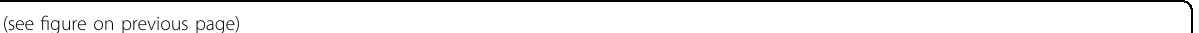
Fig. 1 Prpf19 modulates the poly-ubiquitination and degradation of expanded ATXN3-polyQ protein and also mediates ATXN3-polyQ- induced cytotoxicity. a Overexpression of Prpf19 degraded the level of ATXN3-Q71 and suppressed the ATXN3-Q71-induced caspase-3 cleavage. The expression of ATXN3-Q28 was not affected, and the transcript level of ATXN3-polyQ was not altered when Prpf19 was overexpressed. n = 3 biological replicas. Each n represents an independent preparation of cell protein and RNA samples. b Quanti fi cation of ATXN3-polyQ protein, cleaved caspase-3 protein, and ATXN3-polyQ transcript levels in panel a . Error bars represent S.E.M. Statistical analysis was performed using two-tailed unpaired Student ’ s t test. ns denotes no signi fi cant difference and *** denotes P < 0.001. c Knockdown of Prpf19 increased the level of ATXN3-Q71 and enhanced the ATXN3-Q71-induced caspase-3 cleavage. The expression of ATXN3-Q28 was not affected, and the transcript level of ATXN3-polyQ was not altered when Prpf19 was knocked down. n = 3 biological replicas. Each n represents an independent preparation of cell protein and RNA samples. d Quanti fi cation of ATXN3-polyQ protein, cleaved caspase-3 protein, endogenous Prpf19 protein, and ATXN3-polyQ transcript levels in panel c . Error bars represent S.E.M. Statistical analysis was performed using two-tailed unpaired Student ’ s t test. ns denotes no signi fi cant difference, * denotes P < 0.05 and ** denotes P < 0.01. e Overexpression of Prpf19 promoted the poly-ubiquitination of ATXN3-Q71, and the level of ubiquitinated ATXN3-Q28 was not changed. n = 3 biological replicas. Each n represents an independent preparation of cell protein samples. f Quanti fi cation of the ubiquitination level of ATXN3-polyQ protein in panel e . Error bars represent S.E.M. Statistical analysis was performed using two-tailed unpaired Student ’ s t test. ns denotes no signi fi can t difference and ** denotes P < 0.01. g Knockdown of Prpf19 reduced the poly-ubiquitination of ATXN3-Q71 protein, and the level of ubiquitinated ATXN3-Q28 was not changed. n = 3 biological replicas. Each n represents an independent preparation of cell protein samples. h Quanti fi cation of the ubiquitination level of ATXN3-polyQ protein in panel g . Error bars represent S.E.M. Statistical analysis was performed using two-tailed unpaired Student ’ s t test. ns denotes no signi fi cant difference and ** denotes P < 0.01. Beta - actin or beta-tubulin was used as a loading control. Only representative gels and blots are